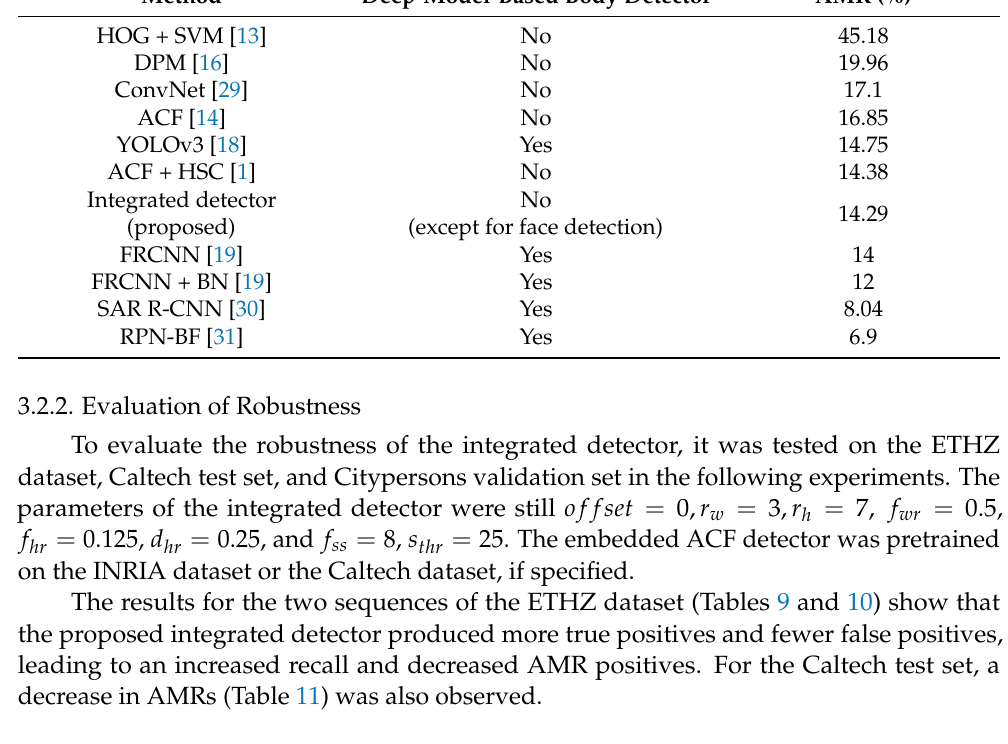
Table 9. Detection results for the BAHNHOF